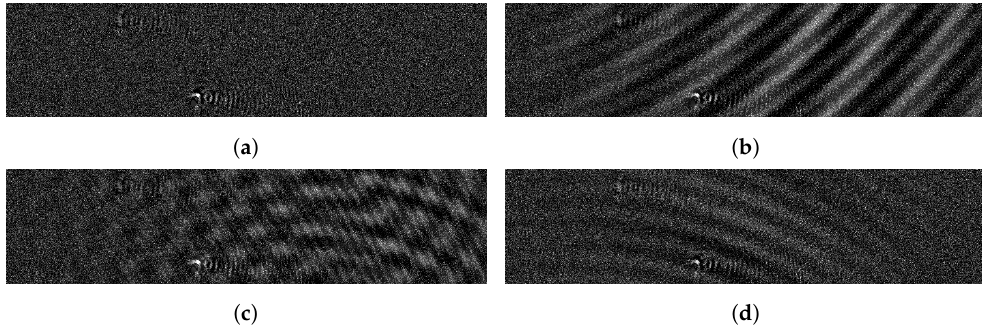
Figure 4. An ( a ) input image and ( b – d ) examples of randomly generated wave